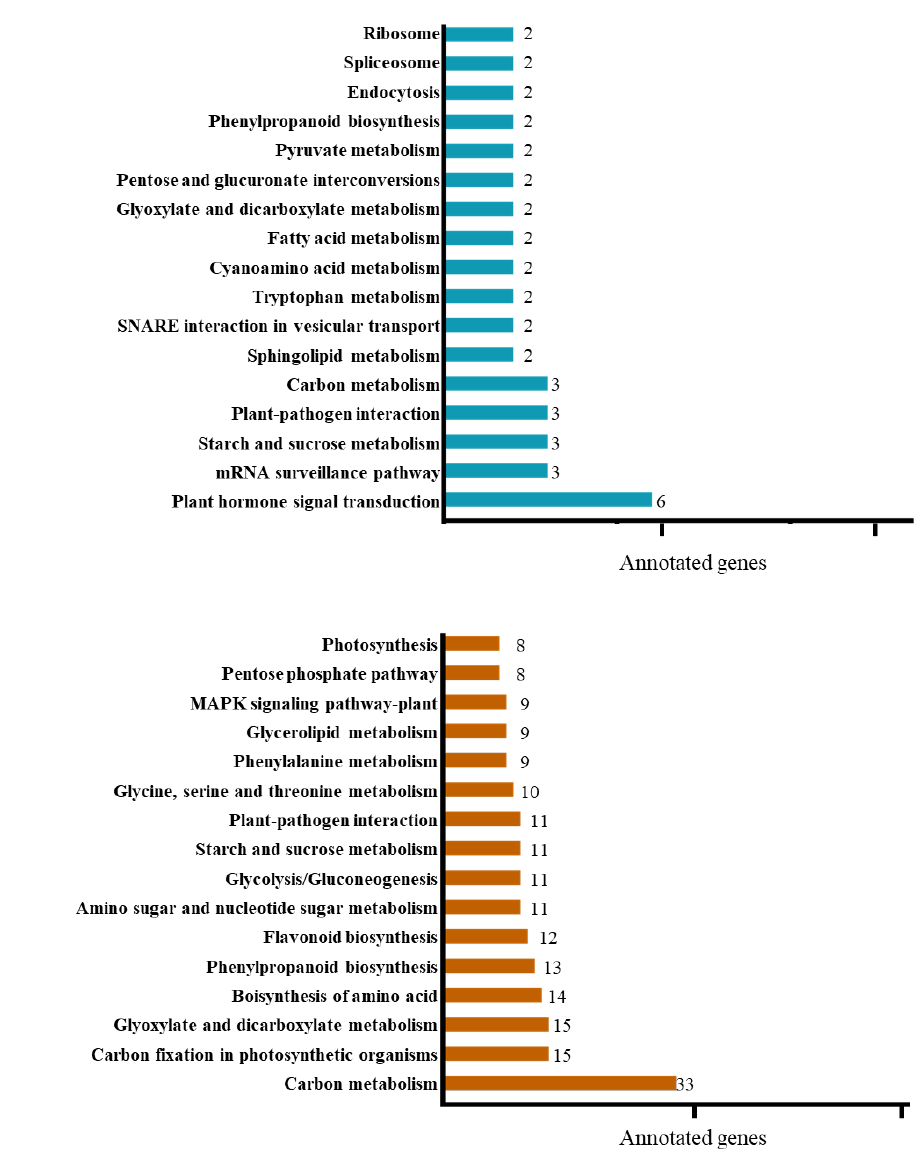
Figure 4. Statistical analysis of annotated unique genes in KEGG pathways in WT (14–345) vs. slf . ( A ) Upregulated genes in KEGG pathways in WT vs. slf . ( B ) Genes downregulated in KEGG pathways in WT vs. slf .